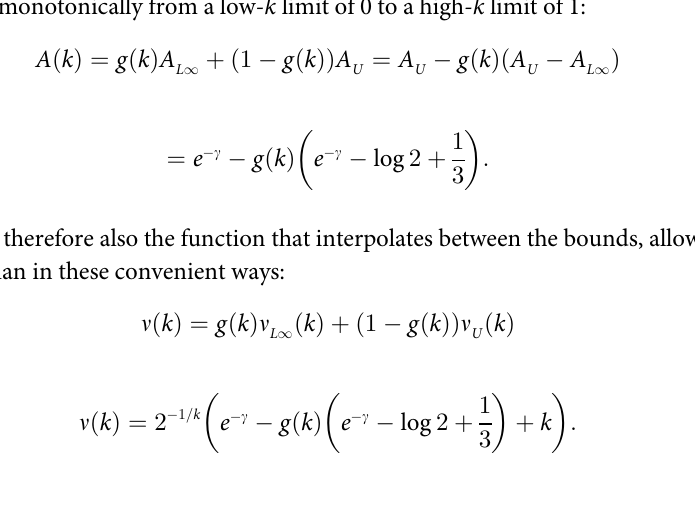
. Modeling either of these U